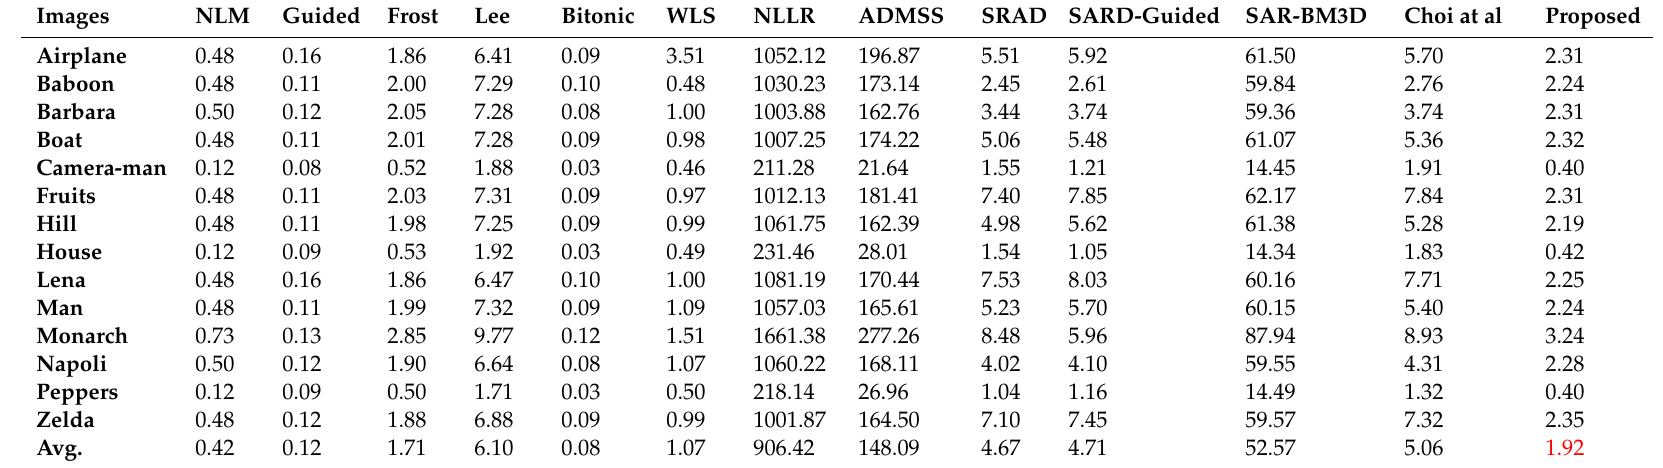
Table 11. Computational complexity results (in seconds) of the despeckling methods for each standard image (512 × 512 and 256 × 256). (the second-best value is shown in red